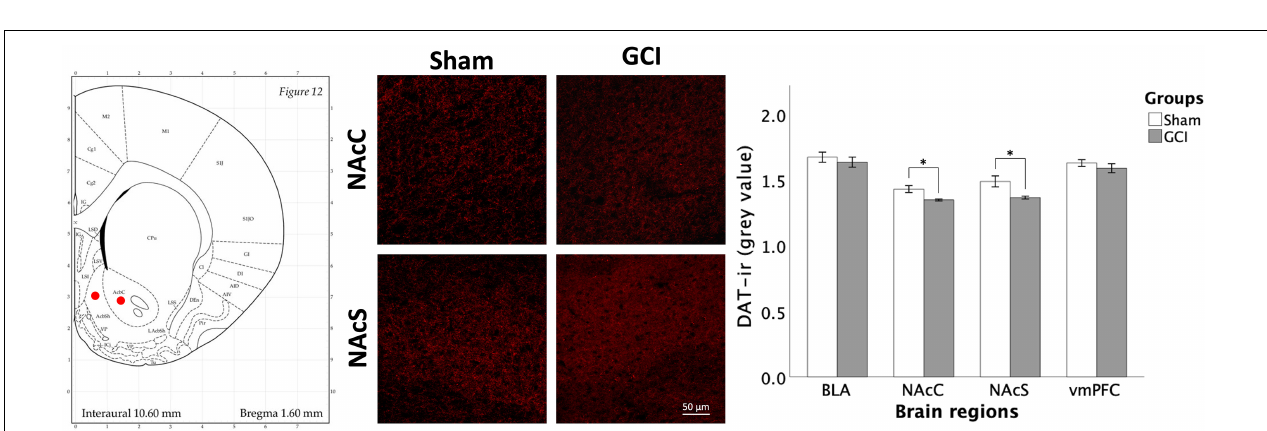
FIGURE 6 | Neuronal injury assessement in the hippocampus CA1 and CA3 regions using thionine staining. Figure shows representative photomicrographs of the CA1 and CA3 subregions of the hippocampus at 20 × magnification (1 mm linear length). Histograms present neuronal density in the CA1 and CA3 following sham surgery or GCI, assessed in 14 µ m thionine-stained coronal brain slices. Values are presented as mean ± S.E.M. ∗ Indicates statistical significance at p < 0.05. Visual representation of rat brain adapted from labs.gaidi.ca/rat-brain-atlas/ (Paxinos and Watson, 2006). GCI, global cerebral ischemia.